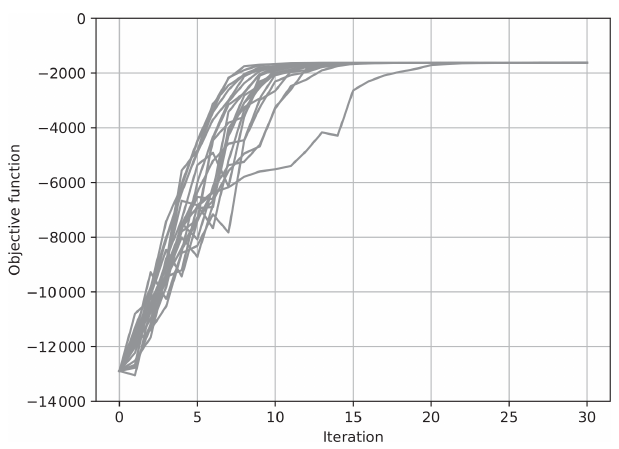
Figure 3. The value of the objective function J for each iteration for 20 trials of the estimation. The ensemble was updated using Eq. (36) with δ = 1 . 5 × 10 − 3 .